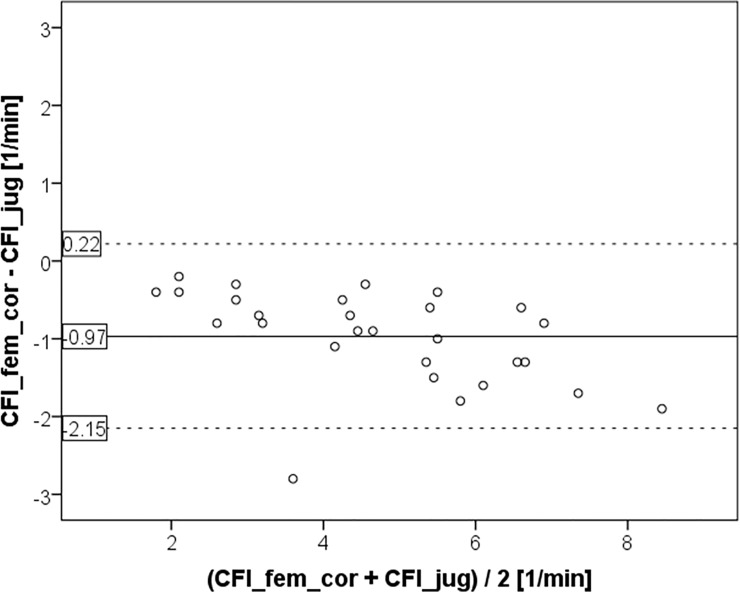
Bland Altman plot comparing cardiac function index CFI_fem_cor derived from femoral injection after activiation of a potential correction by the device to the gold standard measurement CFI_jug using a jugular CVC for indicator injection.